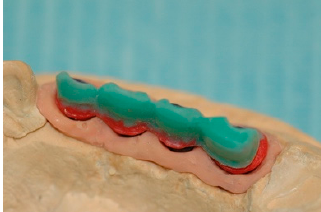
Figure 7. Impression and structure made.